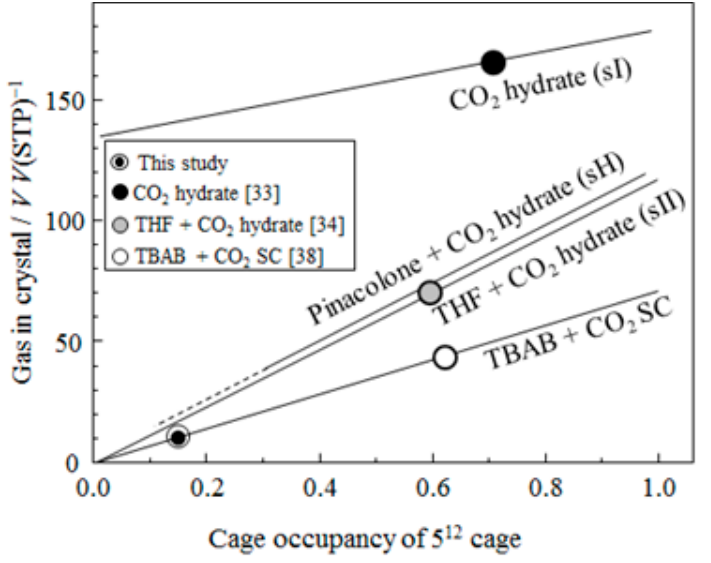
Figure 4. Gas amount contained in semi-clathrate hydrate and gas hydrates as function of cage occupancy of 5 12 cage. Here, cage occupancy of 4 3 5 6 6 3 cage in sH is assumed identical to that of 5 12 cage. Each circle represents experimentally obtained CO 2 gas amount in hydrate crystals, and the result of this study represents the amount of CO 2 + N 2 (CO 2 /N 2 ~0.7/0.3) gas.